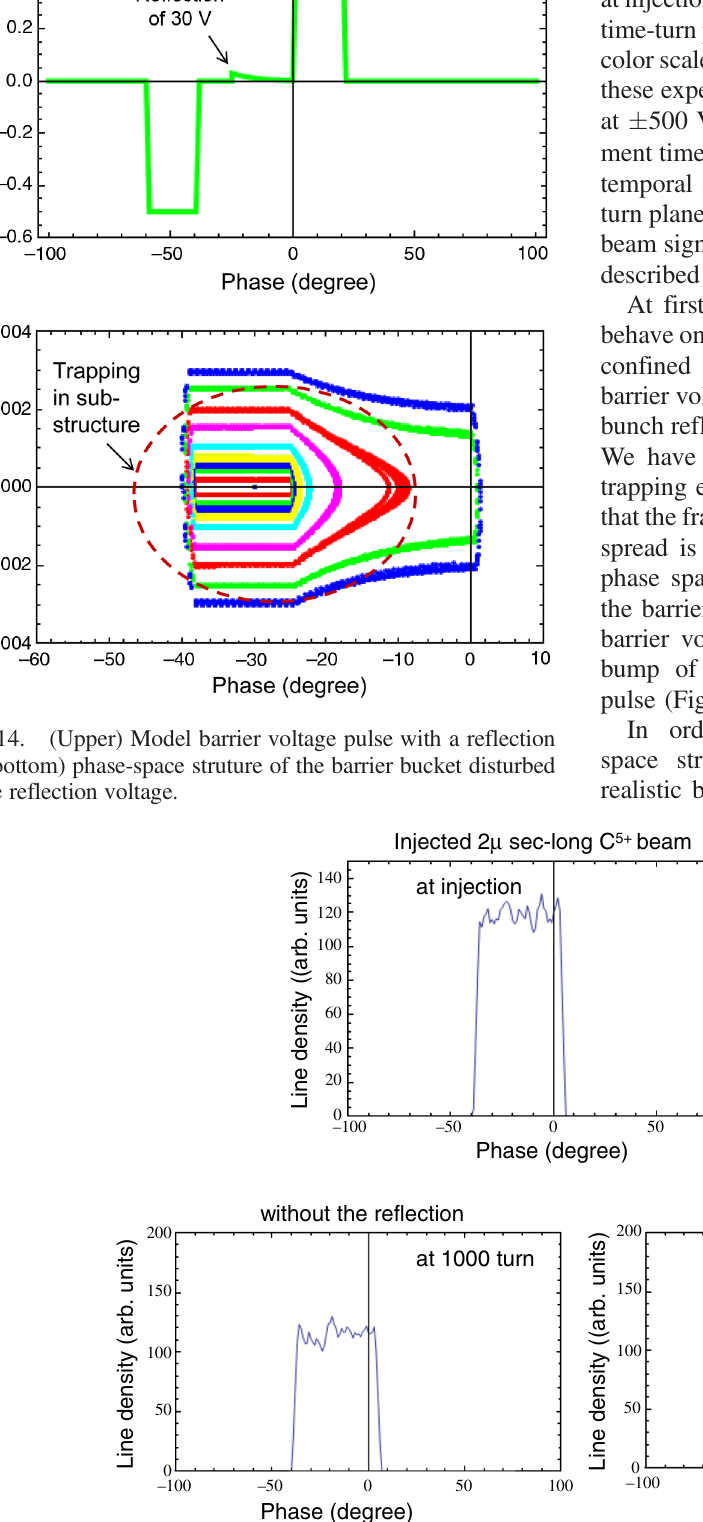
FIG. 15. Multiparticle-tracking simulation from a C 5 þ beam, (upper) the line density of an injected C 5 þ beam pulse uniformly distributed in the longitudinal direction, and (lower) line density after 1000